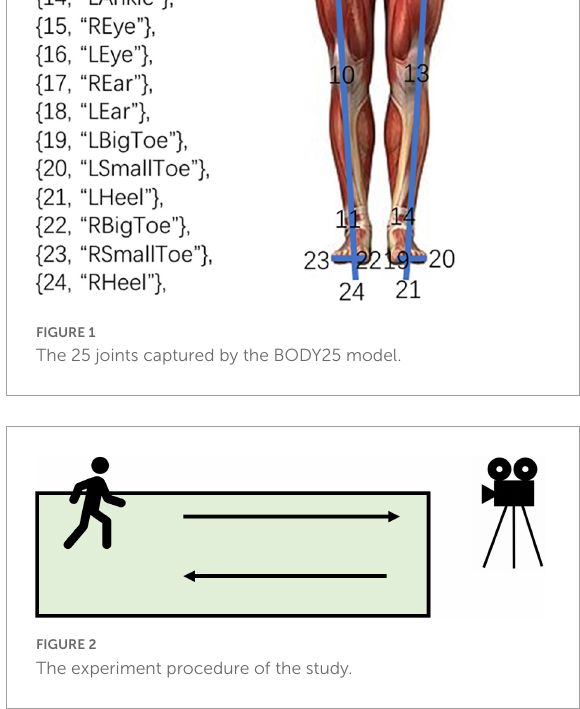
FIGURE2 The experiment procedure of the